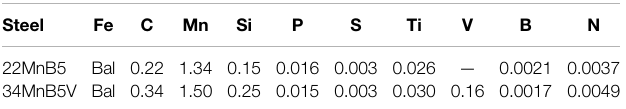
TABLE 1 | The chemical compositions of the studied steels (in